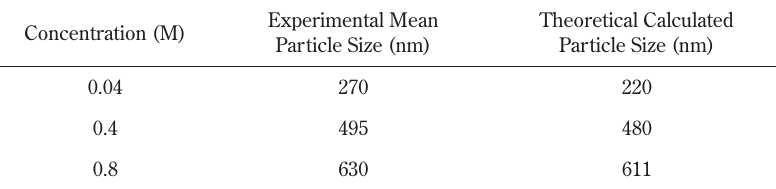
Table 1 Comparison of the experimental obtained and calculated particle sizes Concentration